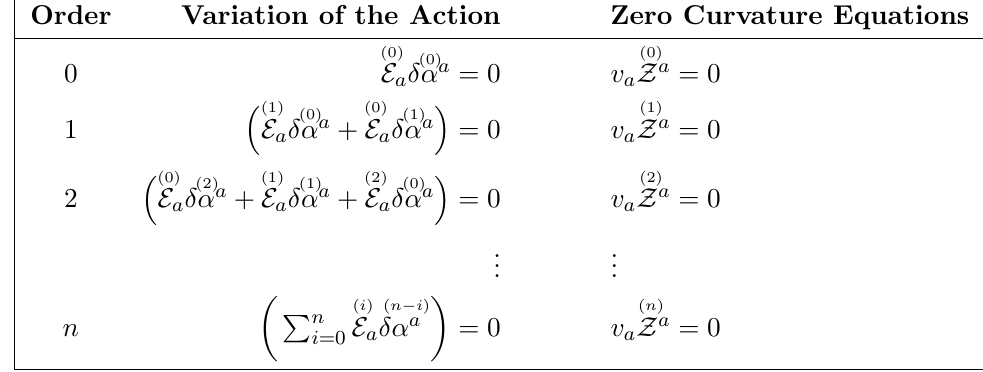
Table 1 . Comparison between the variation of the action and the zero curvature equations order by order in (cid:21)